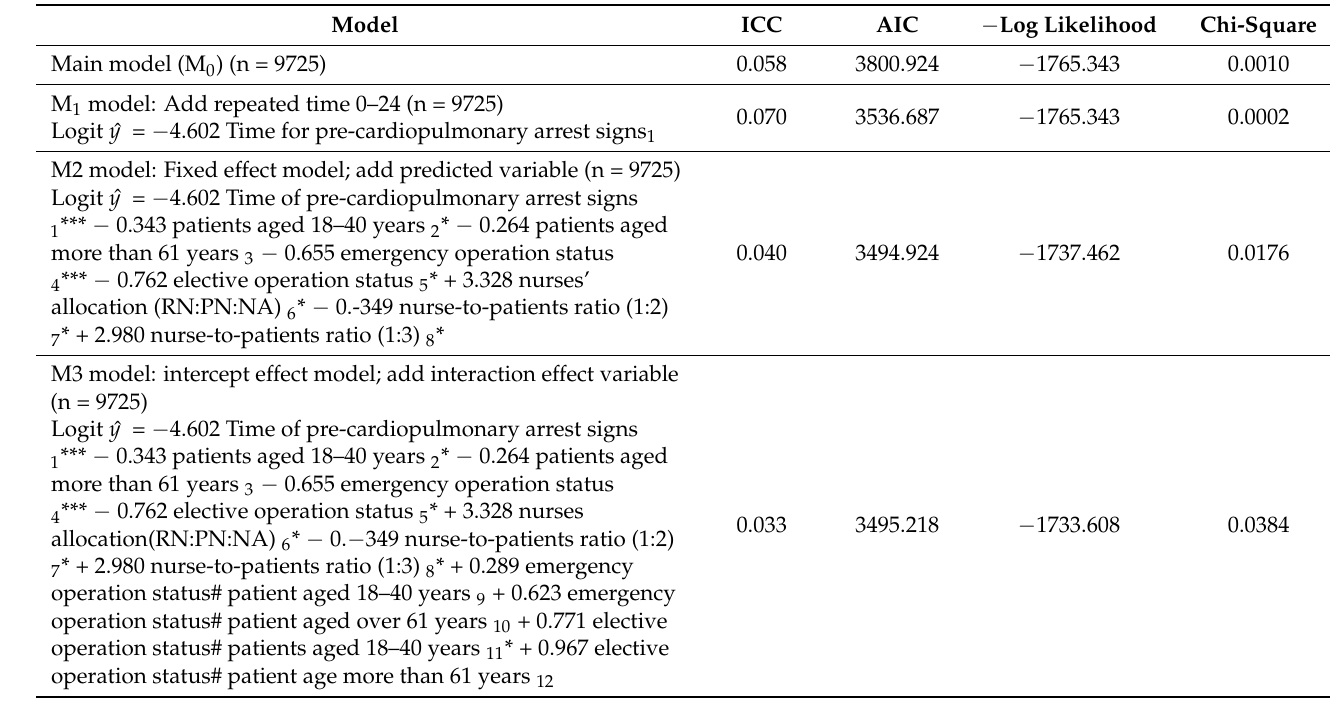
Table 3. Comparison of